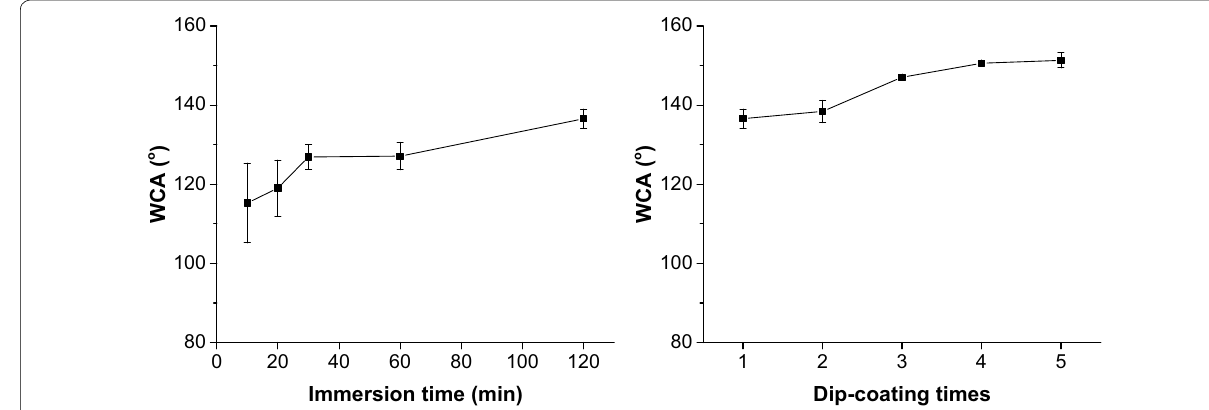
Fig. 7 The effect of immersion time and dip-coating times on WCA